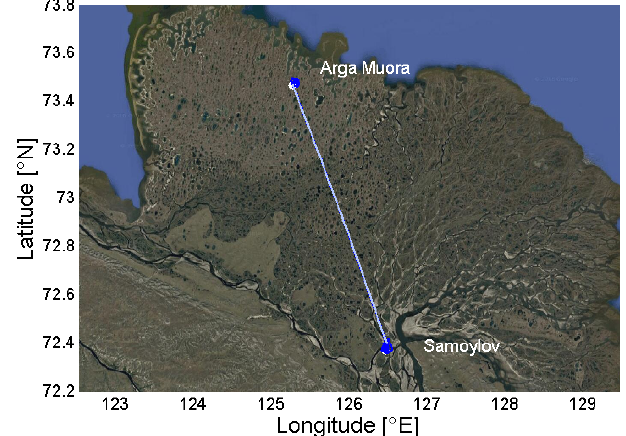
Figure 4. Flight track of the Helipod in the Lena River delta for the measurement flight on 14 August 2014. The flight started at Samoylov Station and went towards Arga–Muora in the north-west. The part of the data used for the analysis is displayed in white. The picture was taken from Google Maps, accessed on 29 May